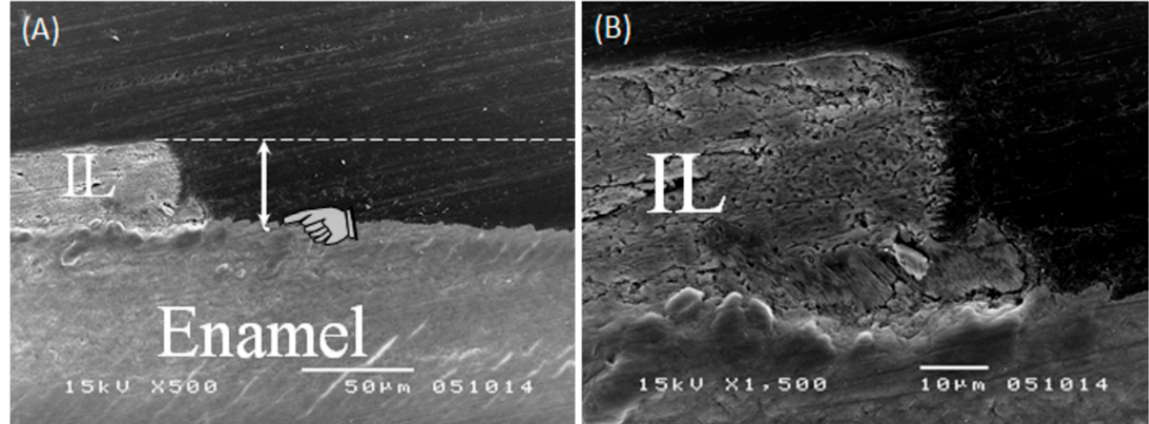
Figure 4. 45S5 bioactive glass re-mineralization for the enamel process. ( A ) Finger pointer pointing to the original enamel surface. Dashed line showing the level that the interaction layer (IL) formed by Bioglass (can reach approximately 40 microns). ( B ) The interaction layer is integrated with the surface of enamel with no gaps observed at this magnification (courtesy of Dr. Ahmed Samir Bakryand Dr. Mona Aly